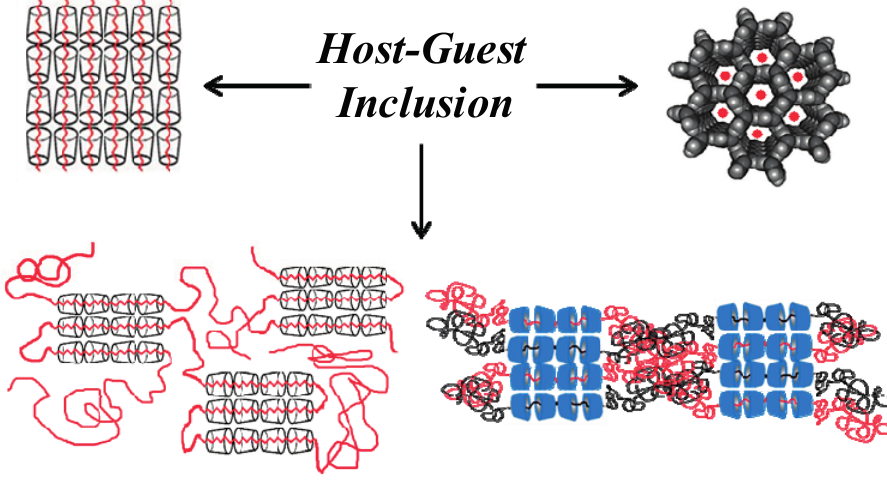
Figure 2. Polymer CD-ICs. ( top left ) and ( top right ) stoichiometric CD- and urea-ICs; ( bottom left ) and ( bottom right ) (n-s)-neat and common mixed